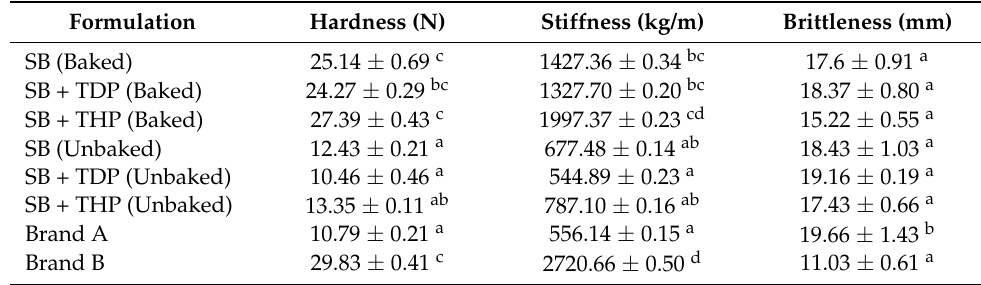
Table 4. Texture analyses of snack bar